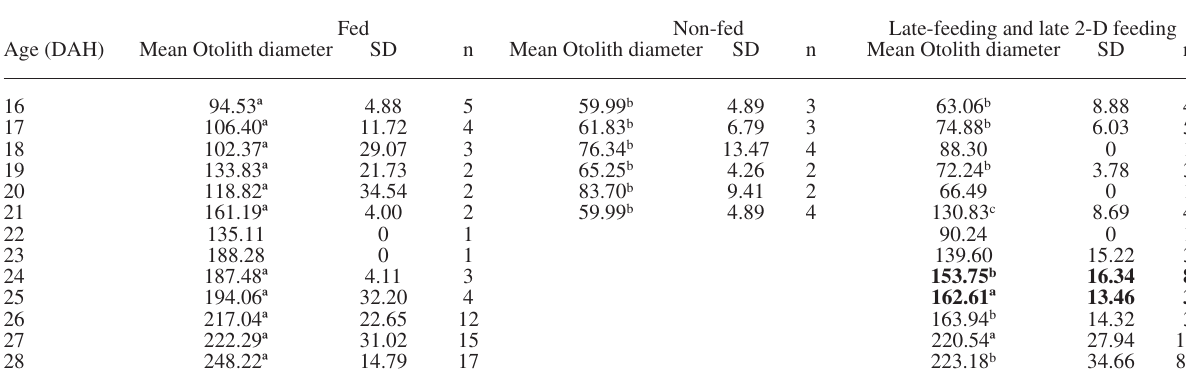
Table 2. – mean maximum otolith diameter ( µ m), standard deviation (sD) and sample size (n) for Dicentrarchus labrax larvae aged 16 to 28 DAH. For a given day, different letters at the mean values indicate significant differences across feeding treatments. in the last group, numbers in bold refer to the larvae sampled during the short food-deprivation event, which were re-fed in subsequent days. Differences were tested using AnovA (3 groups) with tukey’s HsD, or t-tests (two groups). the sample size differs from table 1 because some otoliths could be read for diameter (and were included) but not for daily